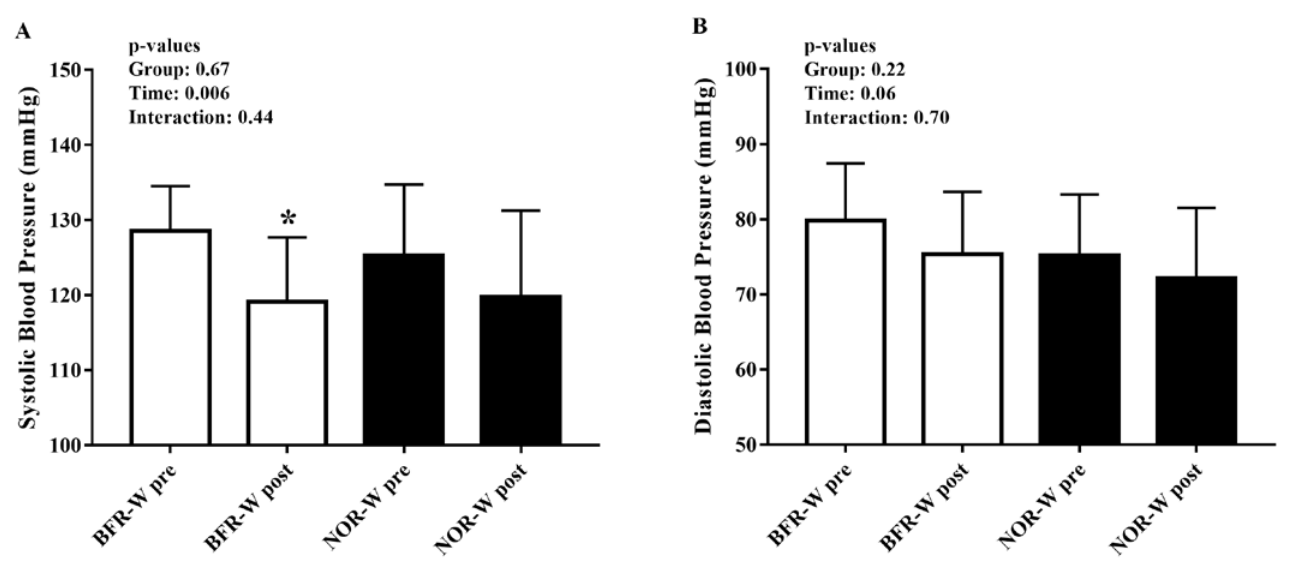
Figure 1. (A) Systolic blood pressure and (B) Diastolic blood pressure following 6-week of walk training with (BFR-W) and without blood flow restriction (NOR-W). * Significant difference (p <